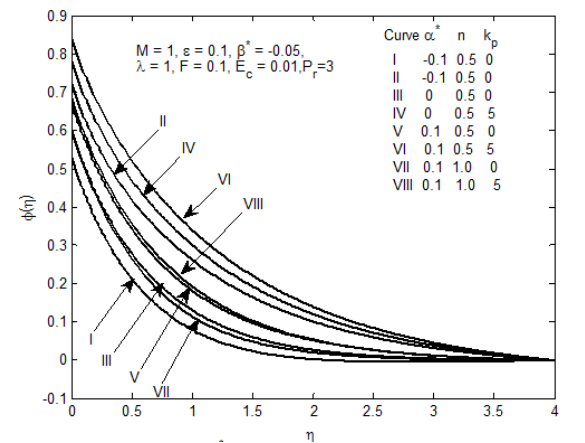
Figure 15: Temperature profiles (PHF case)